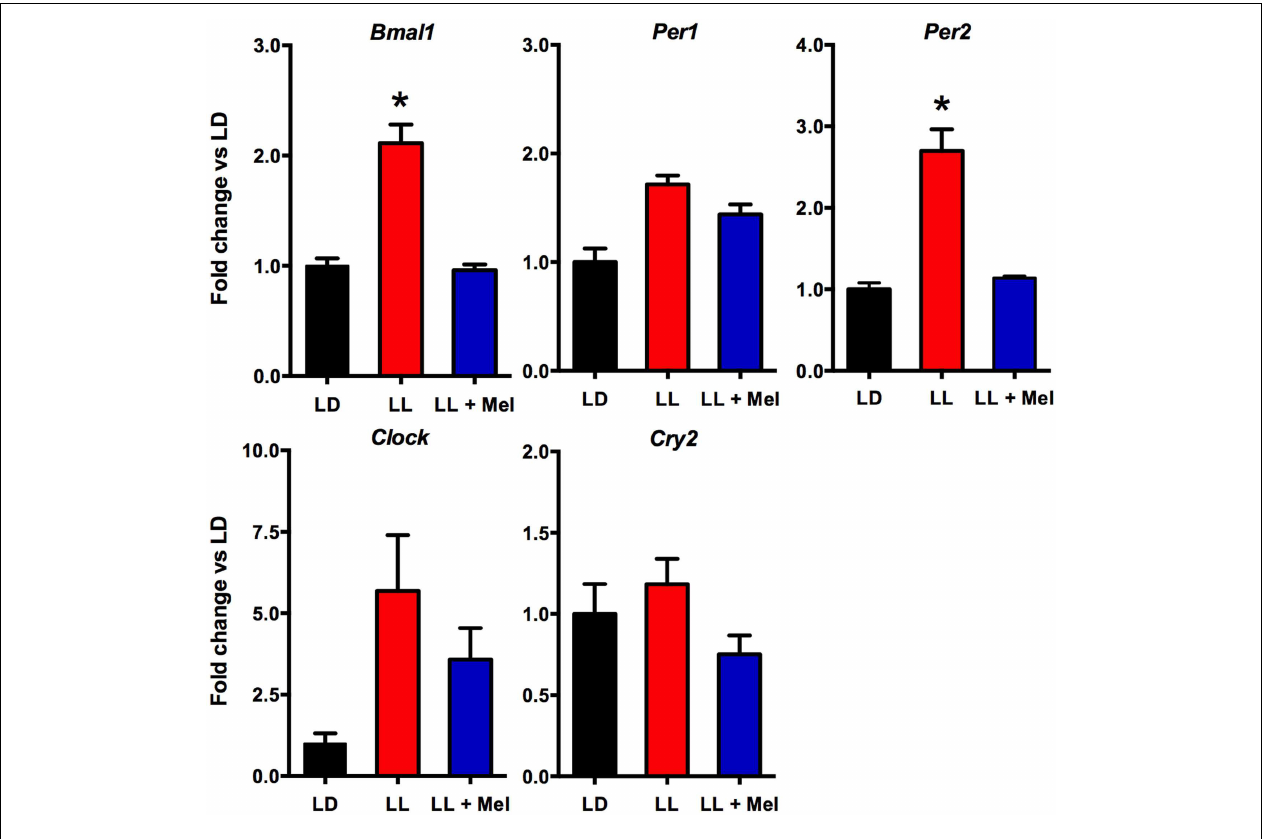
newborns gestated in ewes kept in continuous light but receiving an oral dose of 12mg melatonin at 1700h. LD and LL n = 6. LL +